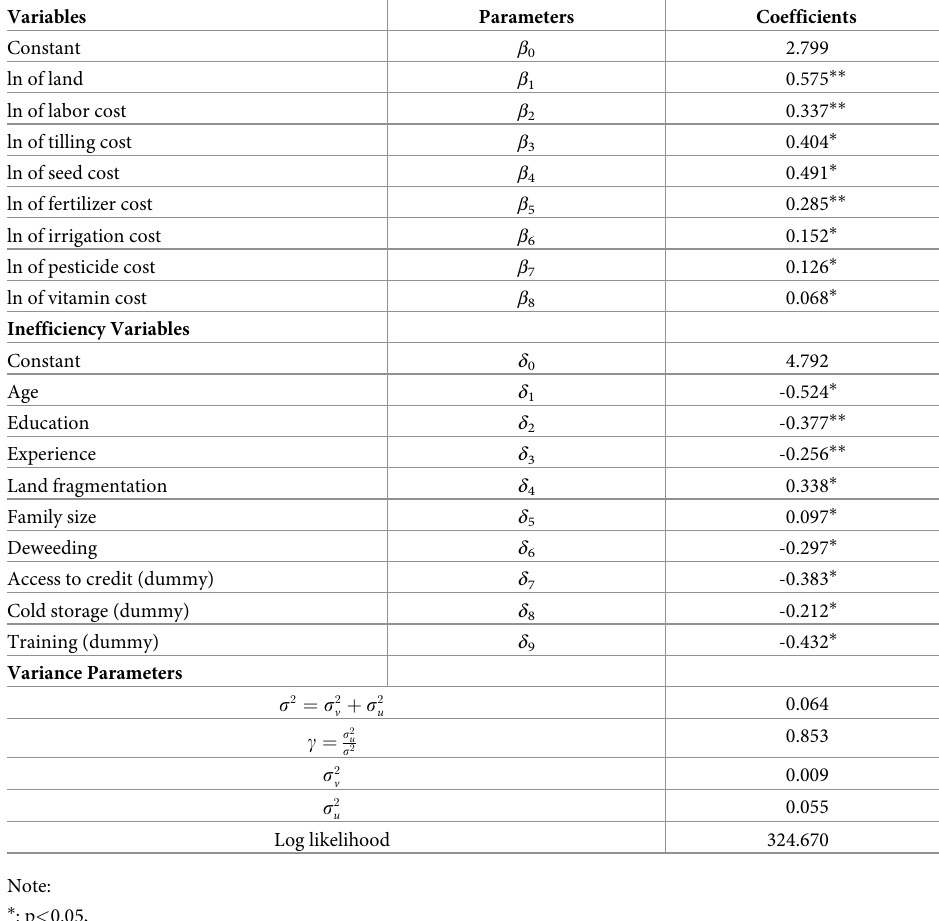
Table 2. Results of Cobb-Douglas stochastic frontier